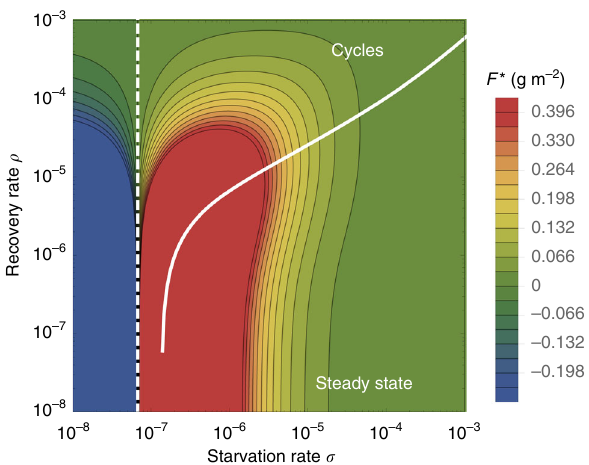
Fig. 1 The transcritical (TC; dashed line) and Hopf bifurcation (solid line) as a function of the starvation rate σ and recovery rate ρ for a 100-g consumer. These bifurcation conditions separate parameter space into unphysical (left of the TC), cyclic, and steady-state dynamic regimes. The colors show the steady-state densities for the energetically replete consumer F *